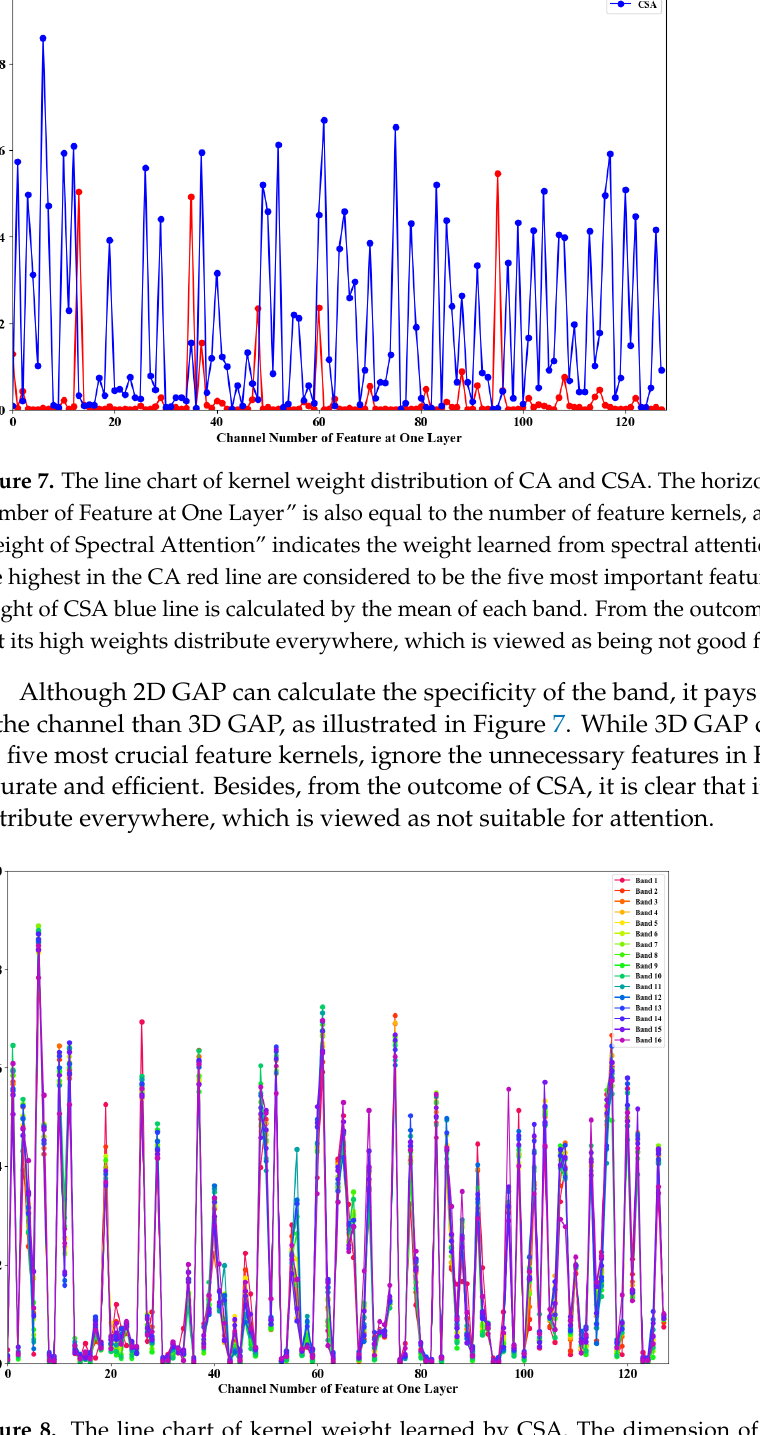
Figure 8. The line chart of kernel weight learned by CSA. The dimension of the feature kernel obtained by 3D Conv is S × C × B × H × W , so the quantity of bands can be changed by the feature kernel of the network, which is not necessarily equal to the number of bands in the HSI. CSA that only uses 2D GAP is more flexible in weight allocation, but its line chart is very confused due to its lack of concentration (i.e., distribute everywhere). It is not as good as the SCA line chart to clearly see important bands and the corresponding interval of important feature channel